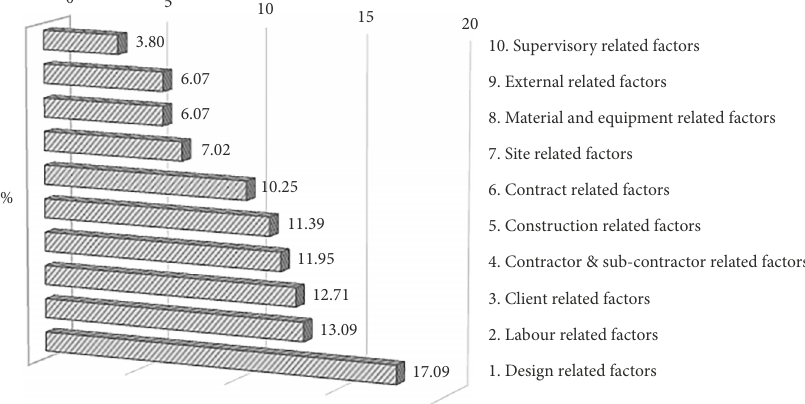
Figure 4. Percentages of rework factors groups in 24 previous